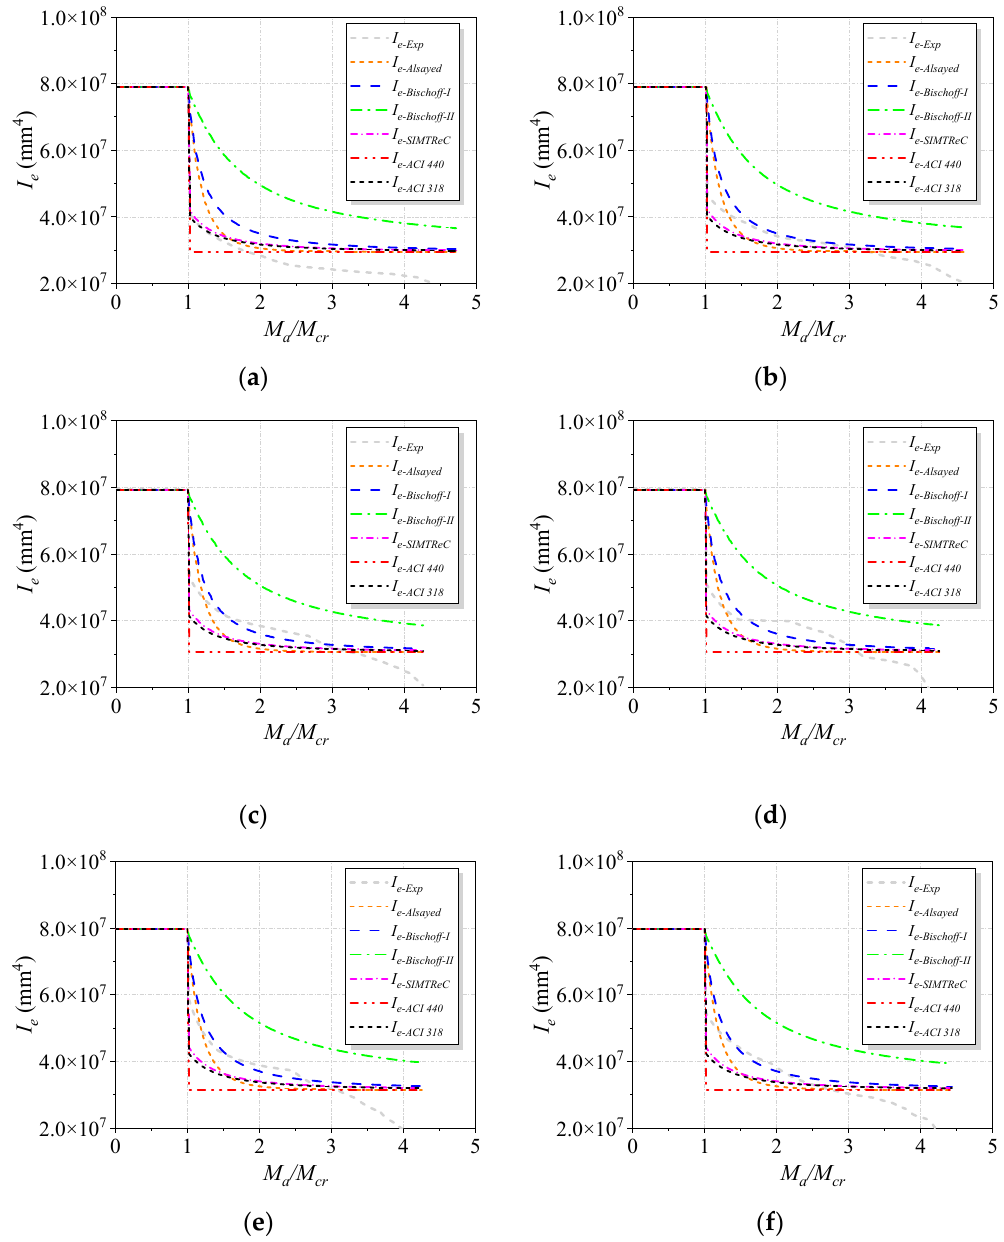
Figure 12. Comparisons between the experimental I e values and predictions for tested beams. ( a ) B0. ( b ) B1. ( c ) B3. ( d ) B3E. ( e ) B5. ( f ) B5E.